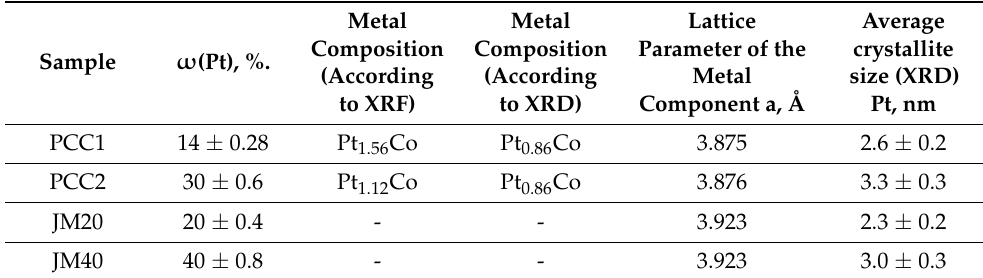
Table 1. Some composition and structure parameters of PtCo/C and commercial Pt/C materials.